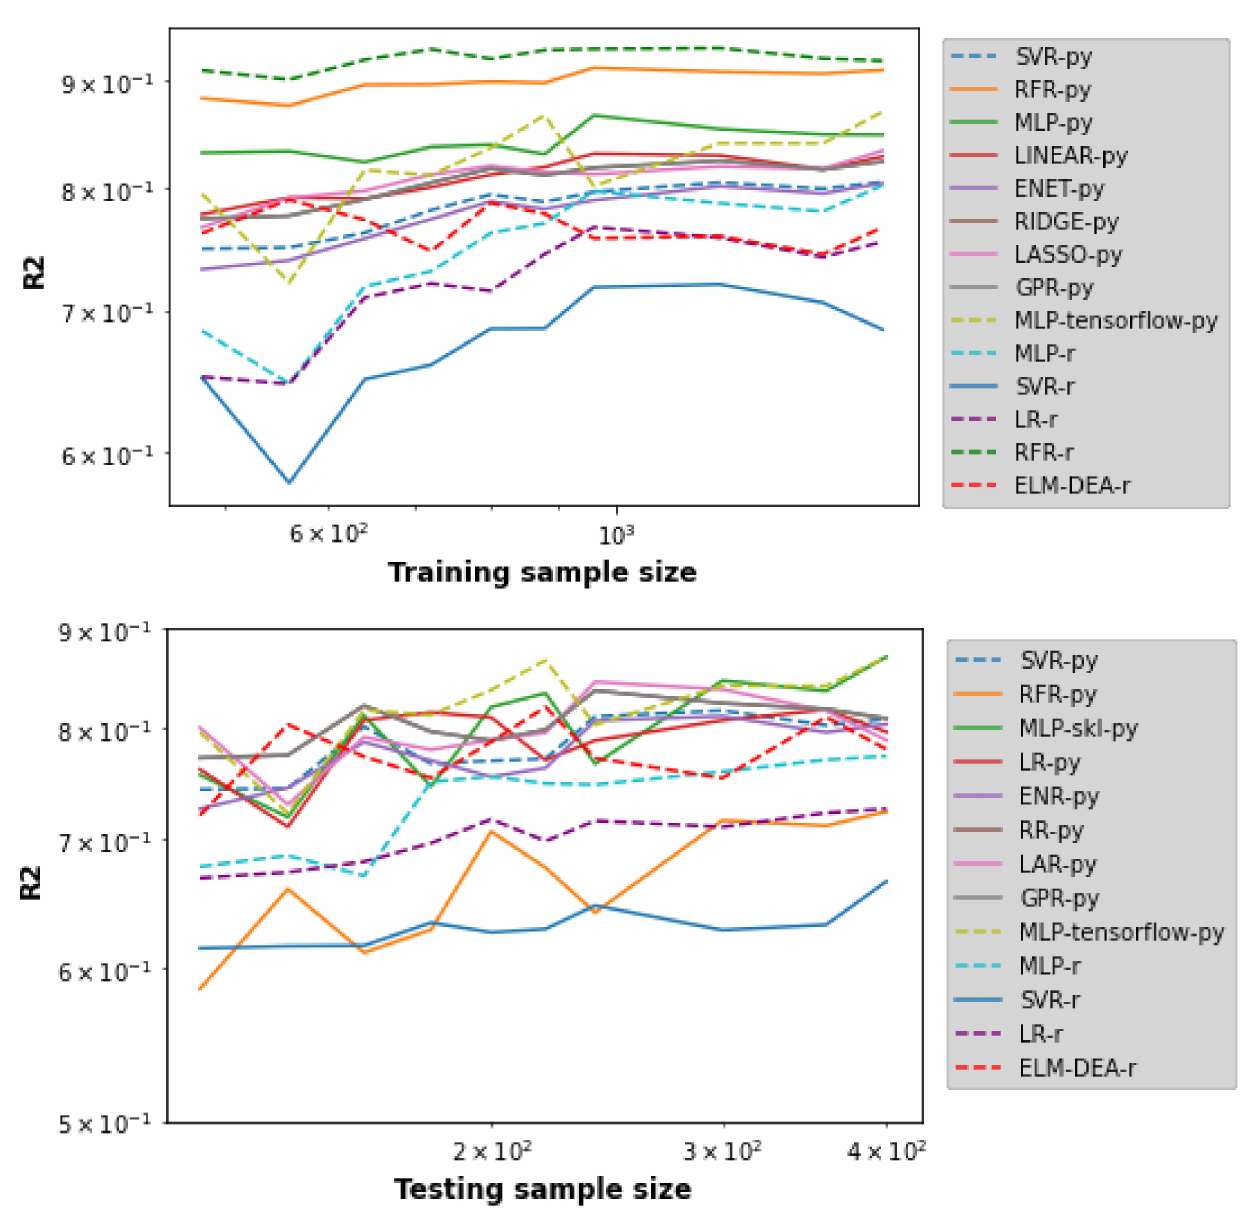
Figure 7. Performance of SML tools to construct SMs for cell bank